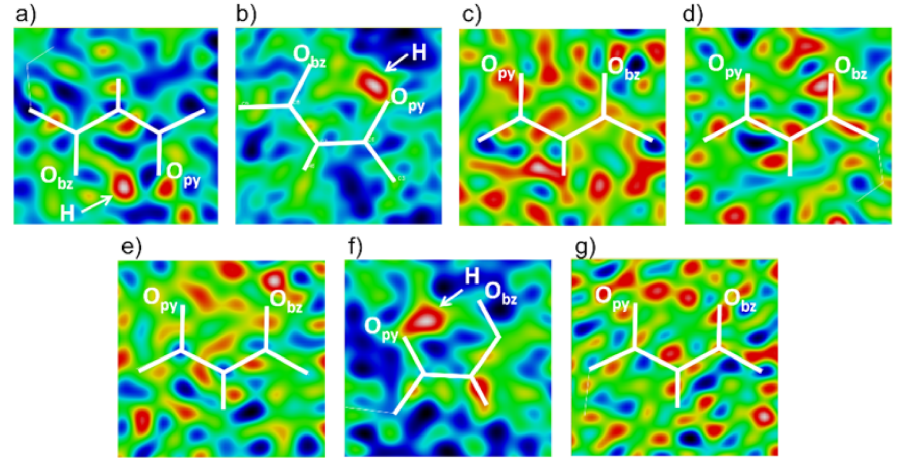
Figure 10. Electron density maps in the plane of the diketo group of ( a ) ( b4pm )( ipfb ); ( b ) ( b4pm )( 12tfib ); ( c – e ) three independent molecules of b4pm in ( b4pm )( 13tfib ): ( f ) ( b4pm )( 135tfib ); ( g ) ( b4pm )( 14tfib ).